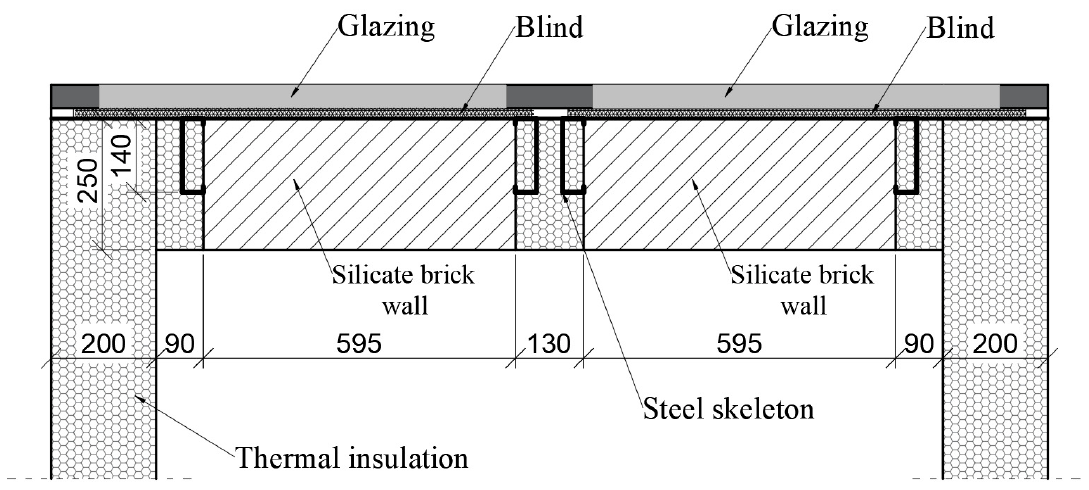
Figure 2. Horizontal cross-section through the tested wall.